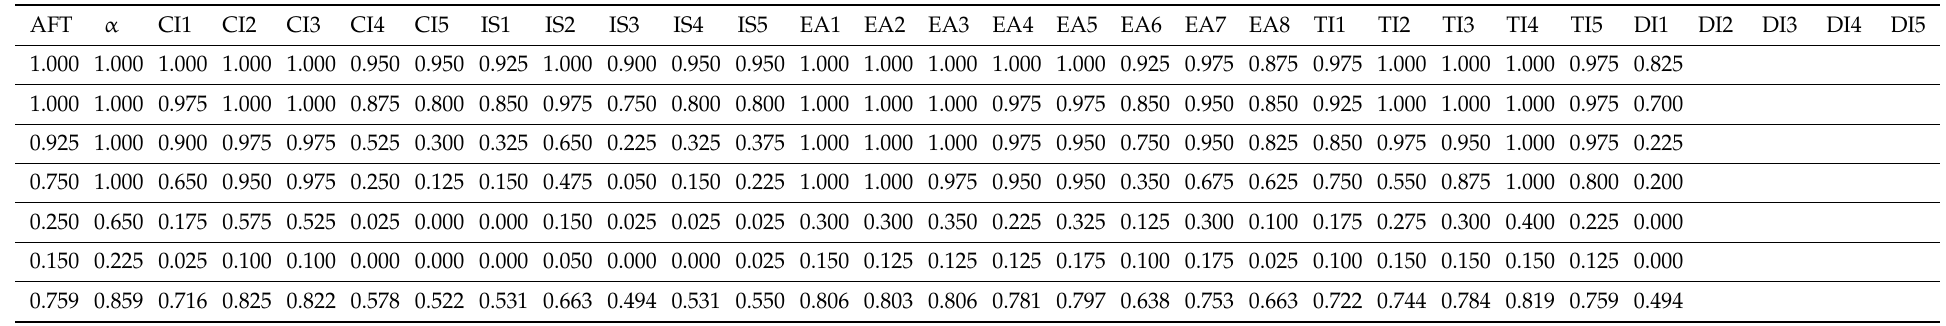
FT: Frequency table; RFT: Relative Frequency Table; AFT: Accumulated Frequency Table; Exp: Experton.